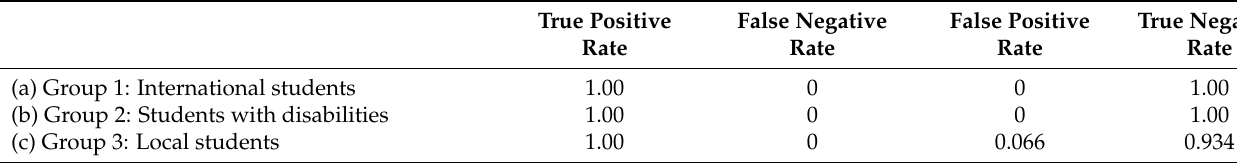
Table 7. Classification results of Case